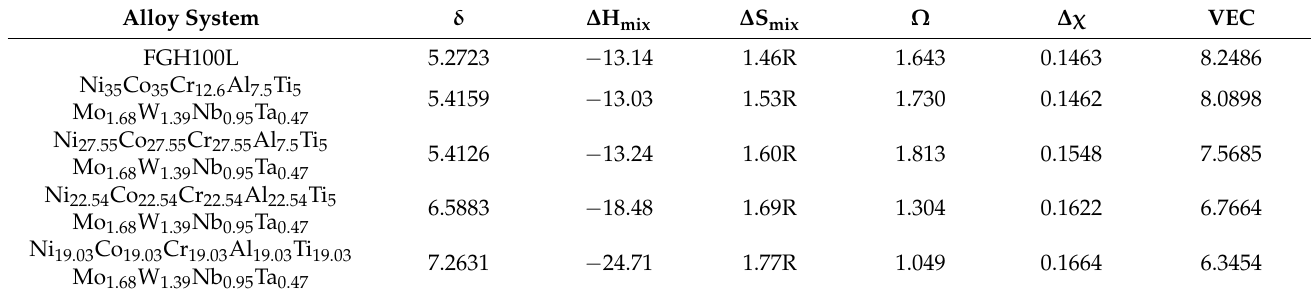
Table 4. The calculated values of δ , ∆ Hmix, ∆ Smix, Ω , ∆ χ , and VEC for the